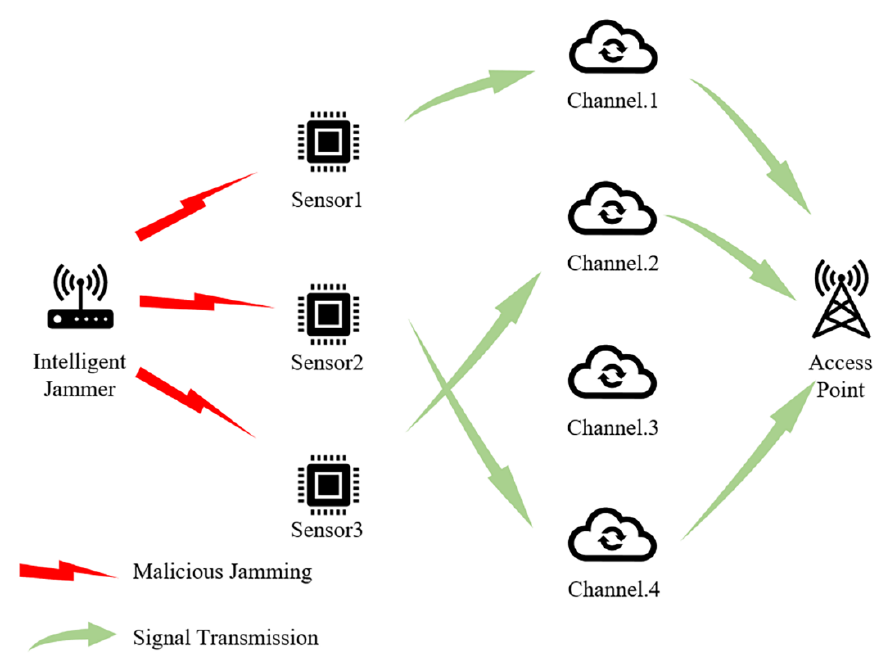
Figure 1. The schematic diagram of system model (take 𝑁 = 3, 𝑀 = 4 as example ) .